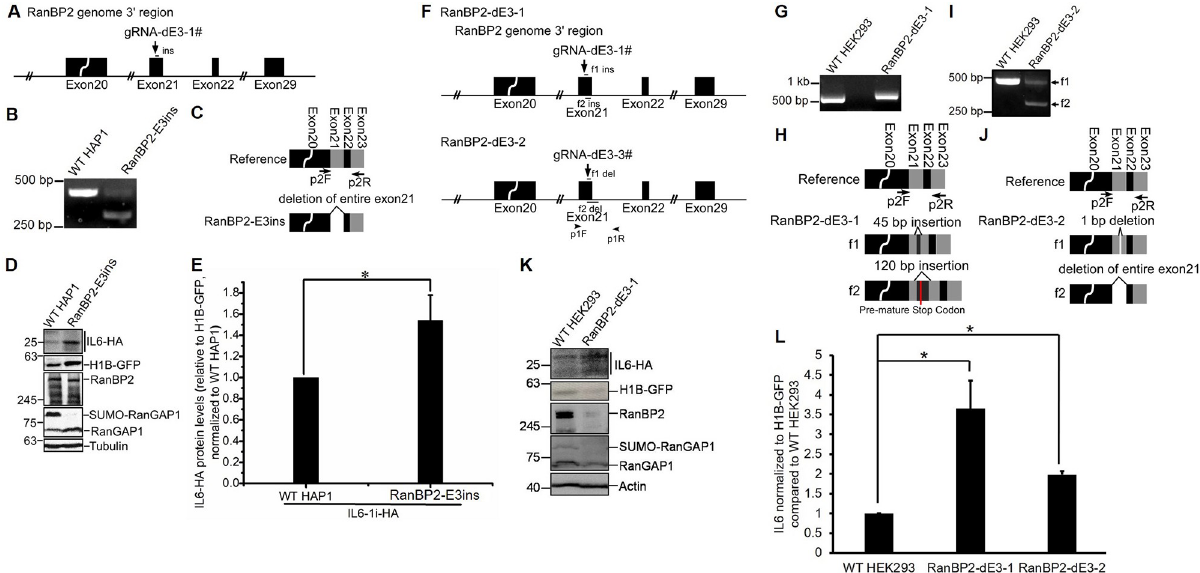
Fig 4. The SUMO E3-ligase domain of RanBP2 is required for the repression of IL6 in HAP1 and HEK293 cells. The SUMO E3-ligase domain of RanBP2 was targeted by CRISPR/Cas9 in HAP1 cells (A-E) and HEK293 cells (F-L). (A) A schematic diagram of the region of the RanBP2 gene in HAP1 cells targeted by CRISPR/Cas9 loaded with the guide RNA “gRNA-dE3-1#”. Note that the insertion “ins” in the RanBP2-E3ins cell line is indicated. (B) cDNA amplification, using p2F and p2R primers indicated in (C), of RanBP2 mRNA. Note that the reaction with the RanBP2-E3ins cell lysates produced an amplicon which was smaller than from unmodified HAP1 cells (“WT HAP1”). (C) Schematic of the modified region in the RanBP2 mRNA. Also indicated are the PCR primers “p2F”and “p2R” for cDNA amplification. Note that the mRNA produced from the modified RanBP2-E3ins gene lacks exon 21. (D-E) Unmodified and RanBP2-E3ins HAP1 cells were transfected with an intron-containing version of IL6-HA ( IL6-1i-HA ) and histone 1B-GFP ( H1B-GFP ). Cell lysates were collected 24 h post-transfection, and IL6-HA was immunoprecipitated with mouse anti-HA antibody and protein G beads (Sigma), separated by SDS-PAGE and immunoblotted with a rabbit anti-HA antibody (top panel). For the detection of other proteins, cell lysates were directly separated by SDS-PAGE and immunoblotted with antibodies against GFP, RanBP2, RanGAP1 and α -tubulin. Note that RanBP2-E3ins cells lacked sumoylated RanGAP1 but expressed RanBP2 at similar levels to unmodified HAP cells (D). IL6-HA and H1B-GFP protein levels were quantified using densitometry analysis and the ratio of IL6-HA/H1B-GFP was normalized to unmodified HAP1 cells, with each bar representing the average of three independent experiments ± SEM (E). (F) A schematic diagram of the region of the RanBP2 gene in HEK293 cells targeted by CRISPR/Cas9 loaded with the guide RNA “gRNA-dE3-1#” to generate the RanBP2-dE3-1 clone or with “gRNA-dE3-3#” to generate the RanBP2-dE3-2 clone. Also indicated are the PCR amplification primers “p1F” and “p1R”, and the regions inserted “f1-ins” and “f2-ins” or regions deleted “f1-del” and “f2-del” in each RanBP2 allele present in the “RanBP2-dE3” clones. (G-I) cDNA analysis similar to (B-C), except for RanBP2-dE3-1 in (G-H) and for RanBP2-dE3-2 in (I-J). (K-L) As in (D-E), except that unmodified, RanBP2-dE3-1 and RanBP2-dE3-2 HEK293 cells were transfected, and cell lysates were directly analyzed by SDS-PAGE and immunoblotting. Note that RanBP2-dE3-1 and RanBP2-dE3-2 HEK293 cells were not assessed in parallel, but each compared to their own parental unmodified cells. The ratio of IL6-HA/HIB-GFP in each RanBP2-dE3 cell line were normalized to unmodified parental HEK293 cells, with each bar representing the average of two independent experiments ± SEM. � P = 0.01–0.05 (Student’s t -test).